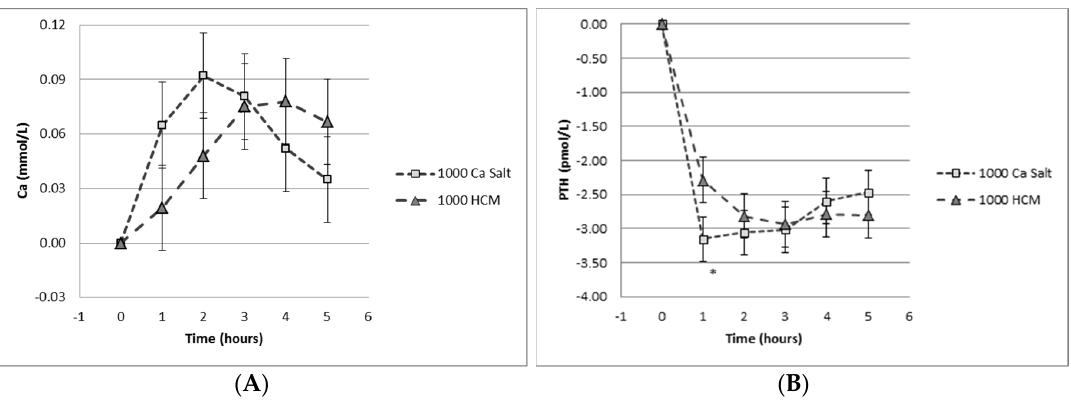
Figure 4. Effect of calcium delivery mode. Graphs depict the response 0–6 hours after the oral intake of 1000 mg calcium salt versus 1000 mg calcium in milk on ( A ) serum calcium and ( B ) serum parathyroid hormone (PTH). Reprinted with permission [74].